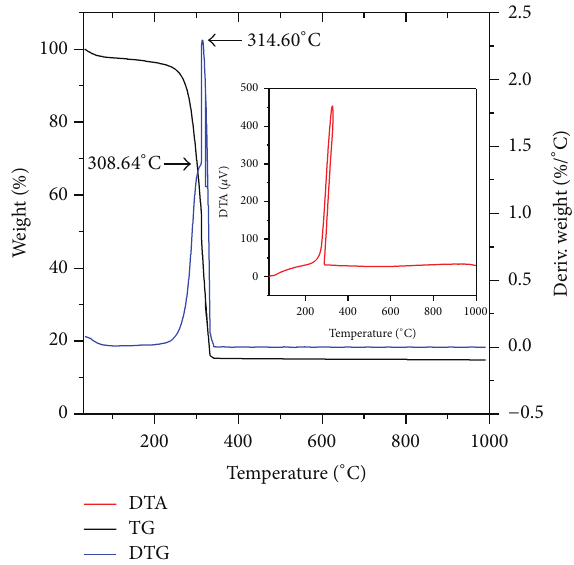
Figure 1: TG/DTG curves with DTA inset of Ce(NO 3 ) 3 /Gd(NO 3 ) 3 / PVP composite nanofibers at a heating rate of 5 ∘ C/min in static